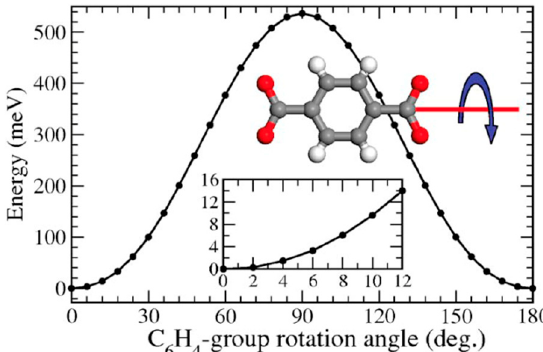
Figure 19. Energy profile for the rotation of a single para -phenylene unit in MOF-5 using density functional theory (DFT) single-point calculations. Reproduced with permission from [17]. Copyright American Physical Society, 2006.